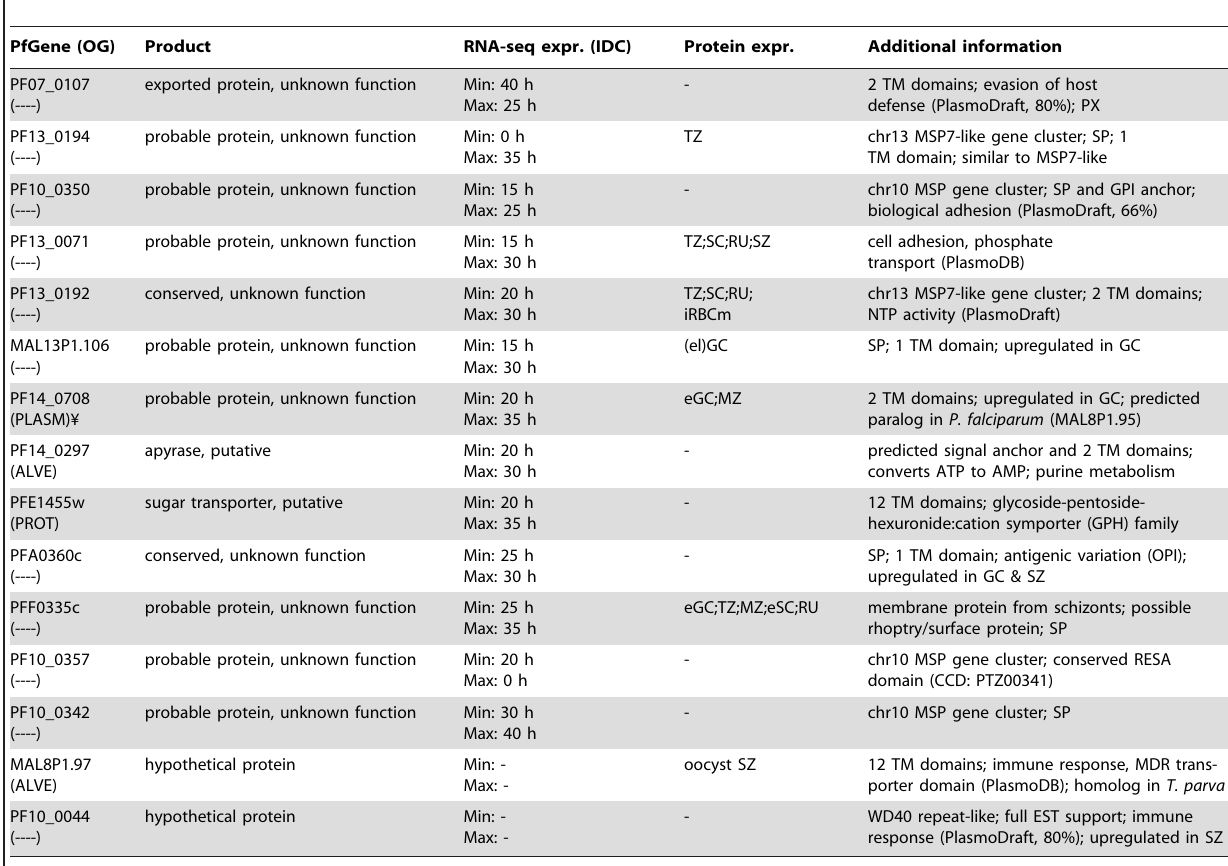
Table 3. P. falciparum genes absent in P. vivax with possible role in human virulence.